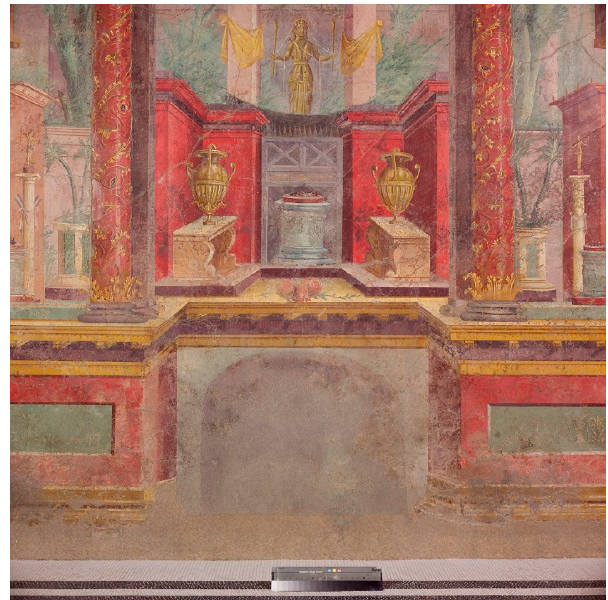
Figure 12. Detail from the Western wall painting of Cubiculum M of Boscoreale (see above Figure 6a,b);